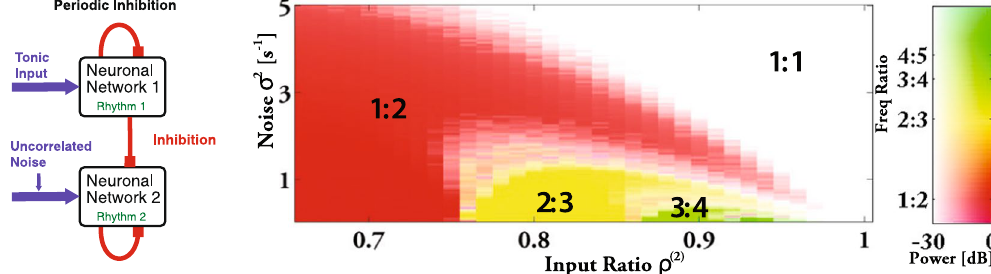
Figure 4. Noise increases the frequency range of entrainment of the periodically inhibited rhythm. ( A ) Periodically forced single network 2. ( B ) Phase diagram for a single network with periodic inhibition. Each neuron in the network receives uncorrelated noise, which synchronizes the rhythm with the forcing in the white region marked 1:1. Parameters and colors as in Fig. 3B9.